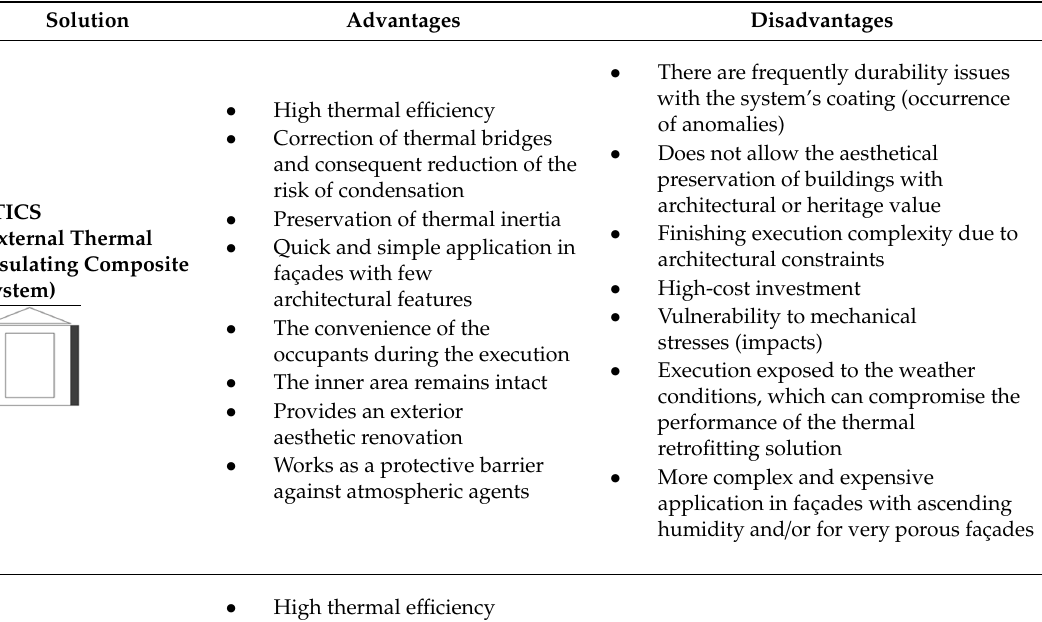
Table 1. Summary of the advantages and disadvantages of each thermal insulation solution for façades